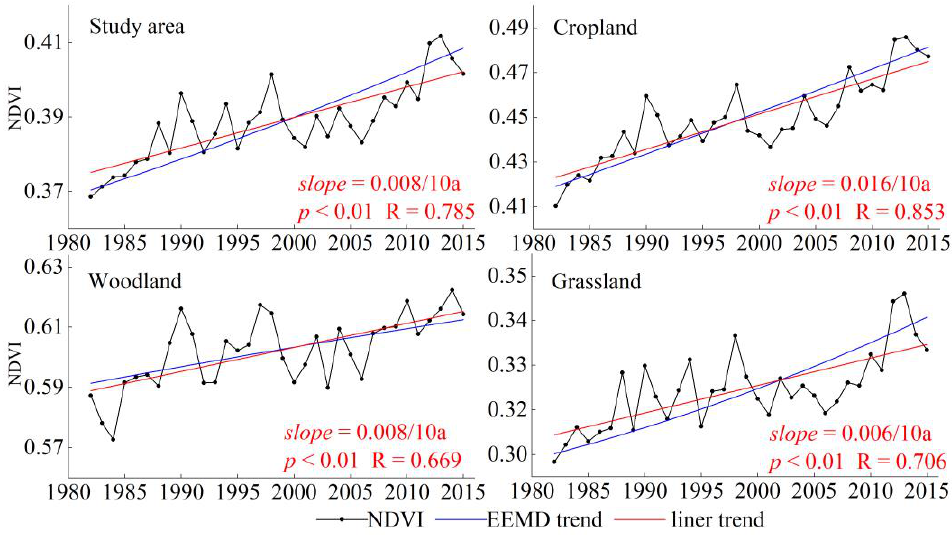
Figure 4. Interannual variation trend of mean GSN of the study area and three different vegetation cover types. The red and blue lines indicate the linear and nonlinear trends, respectively .